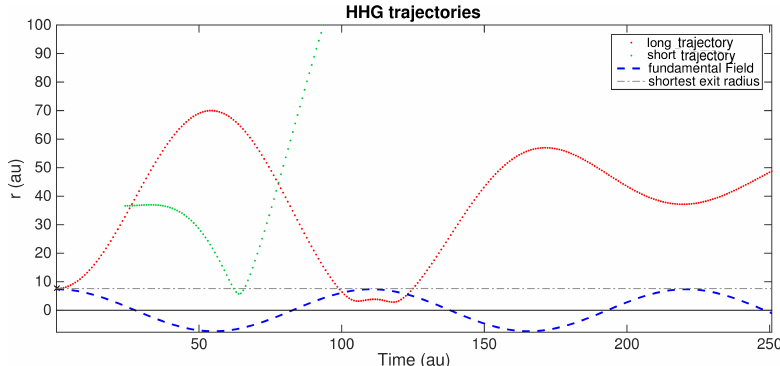
Figure 4. The plot compares two example trajectories from the CTMC calculations. Red dots: ionised immediately at the peak of the field, resulting in a long trajectory. Green dots: short trajectory ionised later in the quarter-cycle. The grey dot-dashed curve represents the shortest exit radius. If this radius is chosen as recombination condition R , then short trajectories travel a relatively large distance from their initially larger exit radius towards the ion nucleus until they cross this radius, while being accelerated by the laser field (blue dashed) that has already turned around. Long trajectories, however, can be decelerated by the field during their approach to the